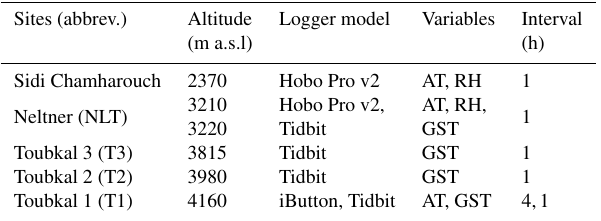
Table 1. Temperature data loggers installed in the High Atlas. Variables: GST, ground surface temperature; AT, air temperature; RH, relative humidity.